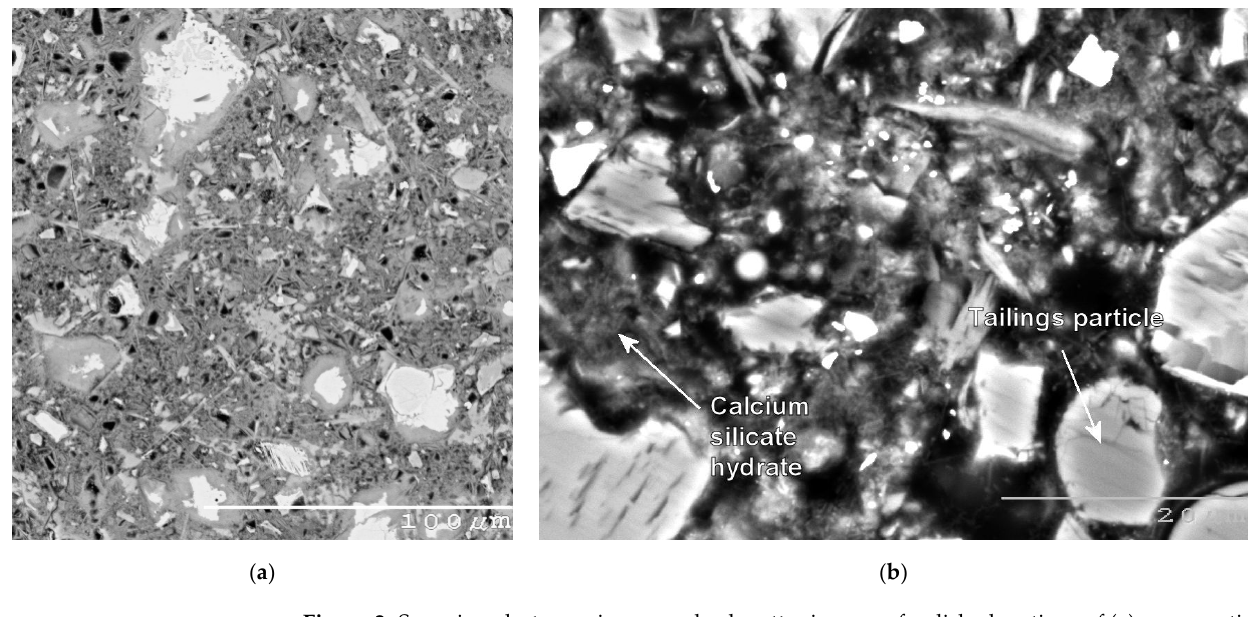
Figure 2. Scanning electron microscope backscatter images of polished sections of ( a ) a conventional mortar with strong network of hydration products (note scalebar 0.1 mm) and ( b ) a CPB with 15% binder content (note scalebar 0.02 mm). (Imaged by Terry Ramlochan, University of Toronto)